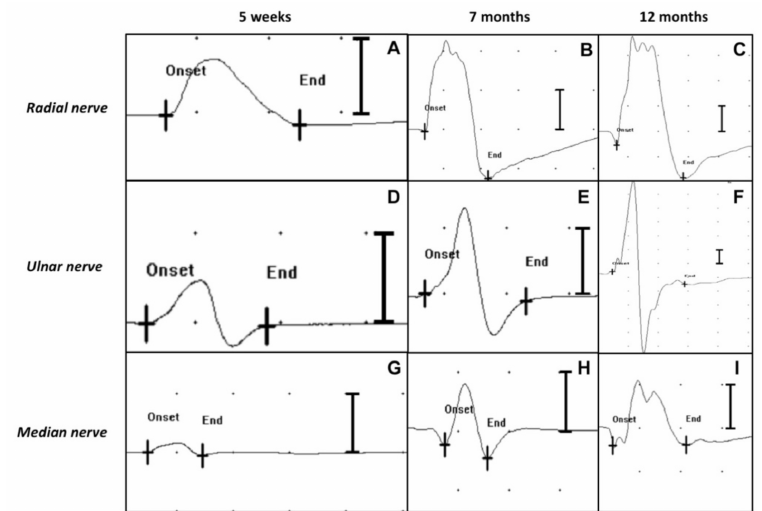
Figure 4. Motor NCS (CMAPs) of the left thoracic limb’s nerves (radial nerve, ulnar nerve, median nerve) at 5 weeks, 7 months and 12 months after admission (distal stimulation). Sweep speed: 5 ms/div. Sensitivity: 2 mV/div. A progressive increase of the amplitudes and areas of the CMAPs over time can be observed in all the tested nerves. ( A ) CMAP amplitude 1.8 mV, area 6.3 uVs; ( B ) CMAP amplitude 7.1 mV, area 23.1 uVs; ( C ) CMAP amplitude 11.2 mV, area 45.7 uVs; ( D ) CMAP amplitude 1.5 mV, area 3 uVs; ( E ) CMAP amplitude 3.9 mV, area 7.5 uVs; ( F ) CMAP amplitude 25.1 mV, area 54.3 uVs; ( G ) CMAP amplitude 0.5 mV, area 0.9 uVs; ( H ) CMAP amplitude 2.5 mV, area 5.3 uVs; ( I ) CMAP amplitude 3.1 mV, area 8.9 uVs.